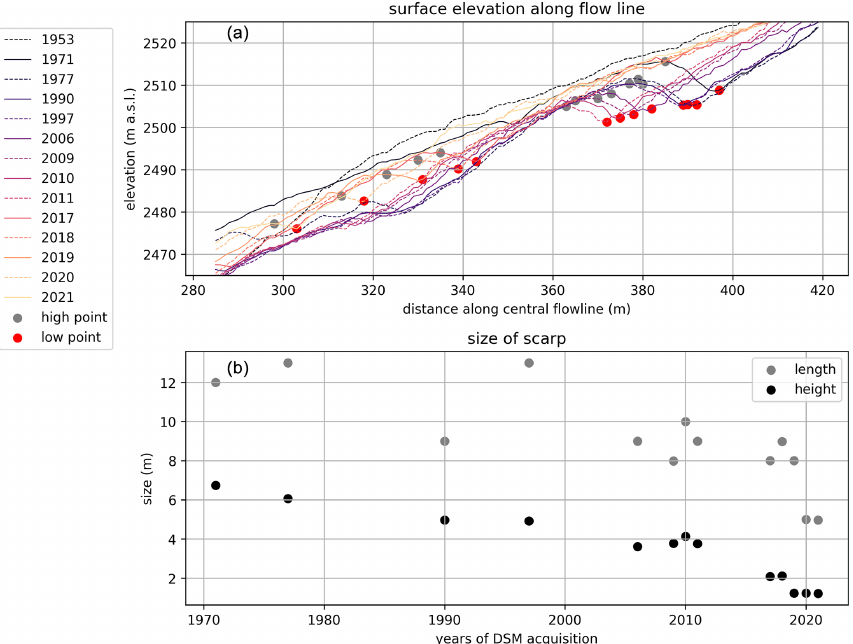
Figure 10. (a) Surface elevation along the flowline as extracted from the DSMs, zoomed in on the scarp in zone B, as marked in Fig. 7, and approximate locations of the bottom of the scarp and the high point of the displaced material. The scarp is not yet present in 1953. (b) Height and length of the scarp in different years (height is the vertical distance between the respective grey and red dots in a ; length is the horizontal distance).